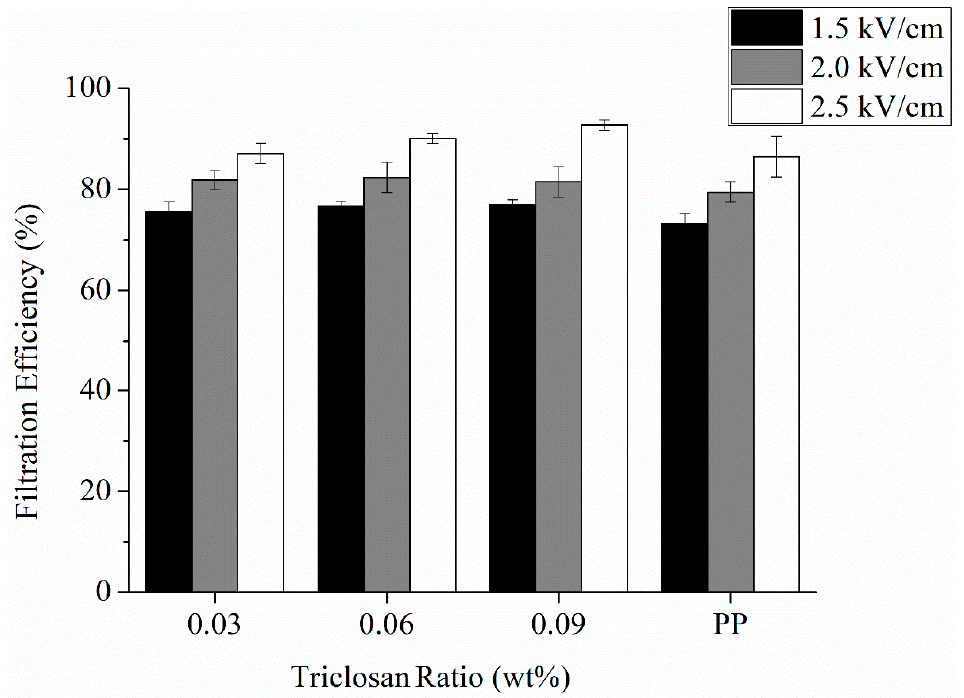
Figure 5. Filtration efficiency of antibacterial electret PP filters as related to triclosan amount (0.03, 0.06, and 0.09 wt%) and electric field intensity (1.5, 2.0, and 2.5 kV/cm). The control group (electret pure PP nonwoven fabrics) contains 0 wt% of triclosan.